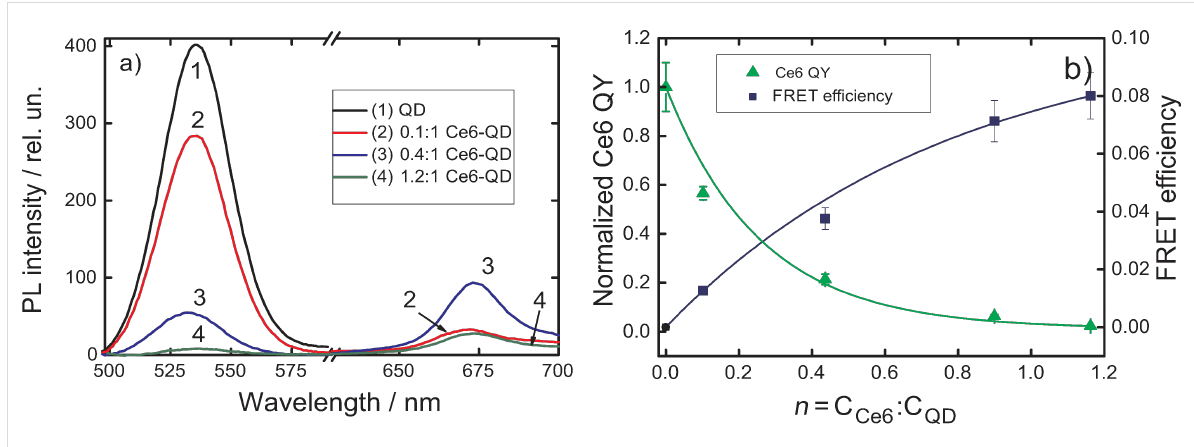
Figure 5: Optical properties of QD–Ce6 complexes formed by electrostatic interaction in the PET membrane as a function of n . (a) Evolution of PL spectra of 2.5 nm QDs and Ce6 complexes. PL excitation wavelength is 475 nm. (b) FRET efficiency, estimated using Equation 5 and Ce6 QY as a function of n .